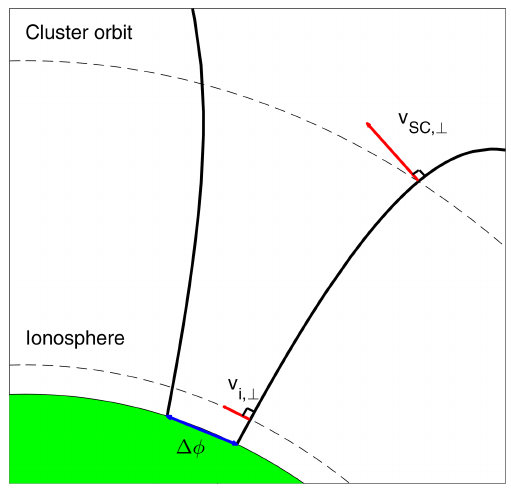
Figure 5. Illustration of rescaling convection measurement to iono- spheric height. The measured velocity at the spacecraft location, v SC ⊥ , is scaled to ionospheric height v i , ⊥ . (cid:49)φ is cusp latitudinal extent at the surface of the Earth. Black lines represent the most sunward and most tailward cusp field lines,